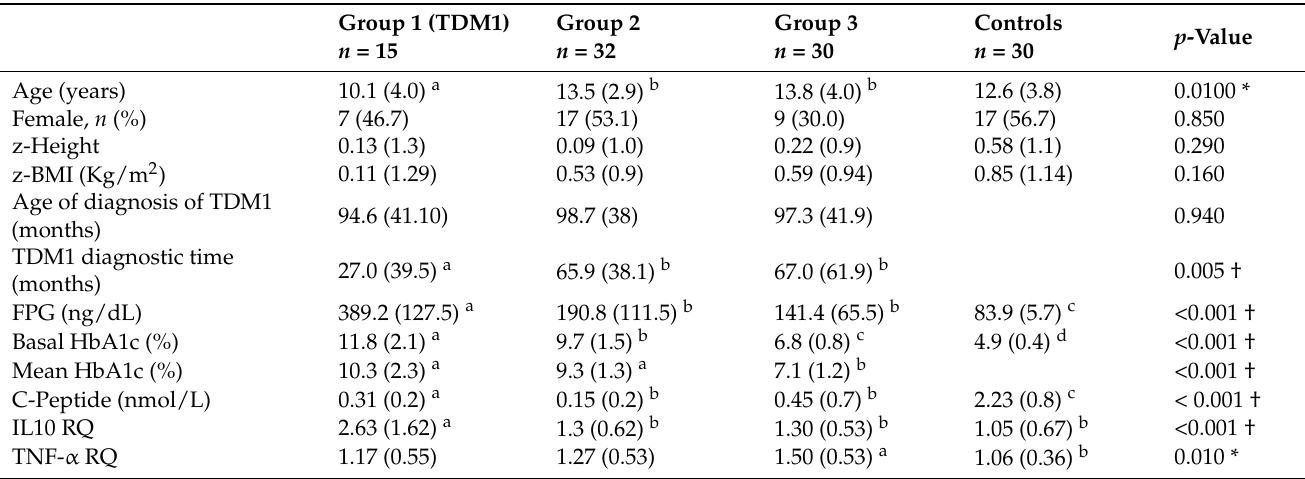
Table 2. Comparison of mean and standard deviation (SD) of quantitative variables between study